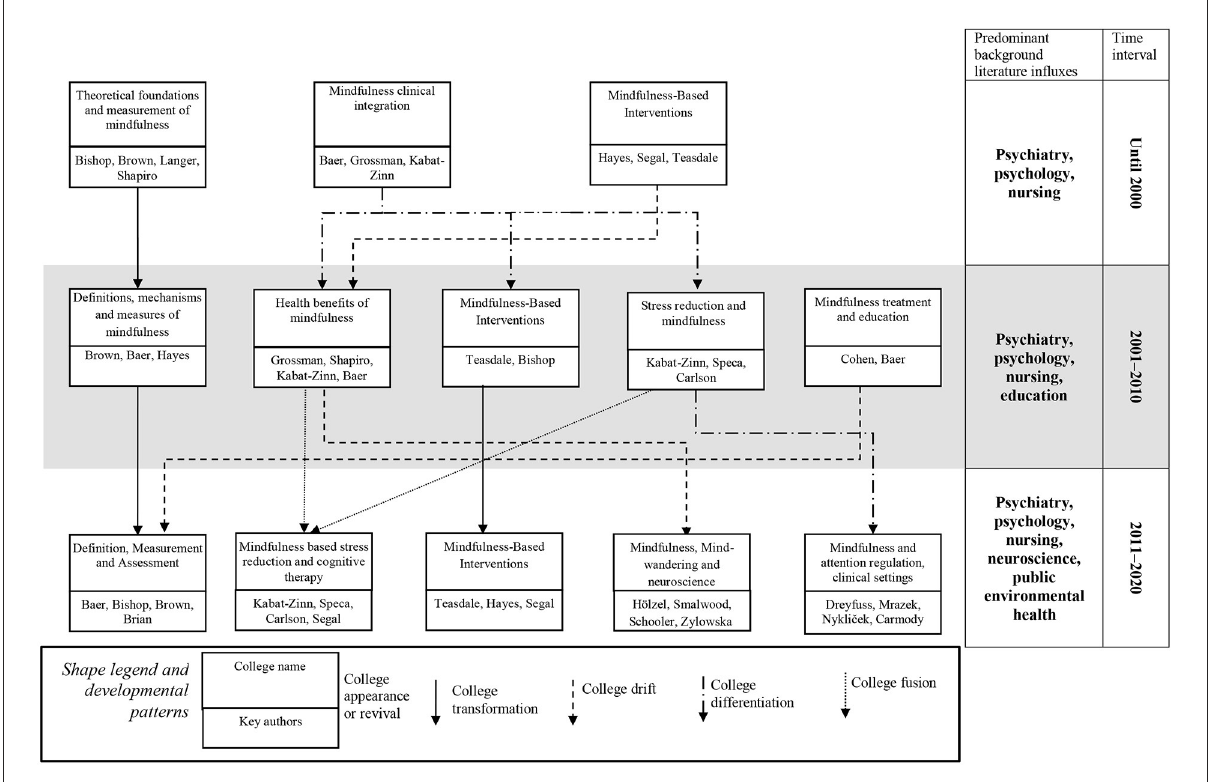
FIGURE2 Development patterns of mindfulness research based on the invisible colleges